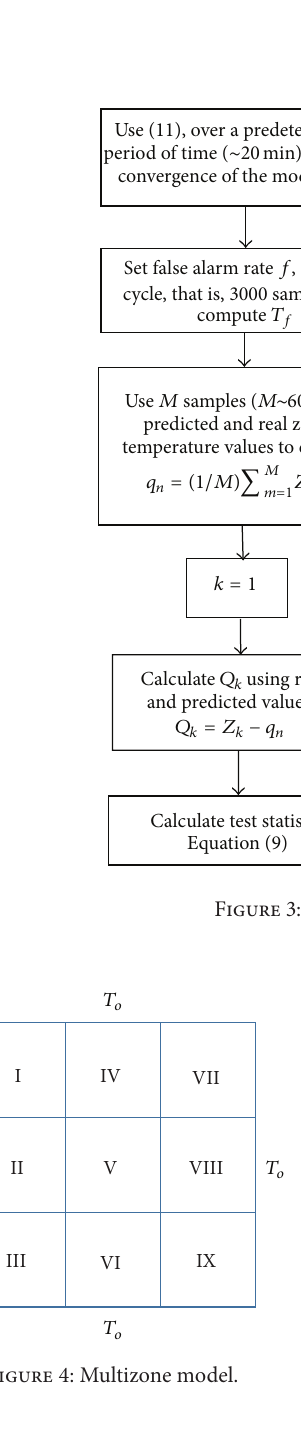
Figure 5: Empirical estimation of 𝑇 𝑜